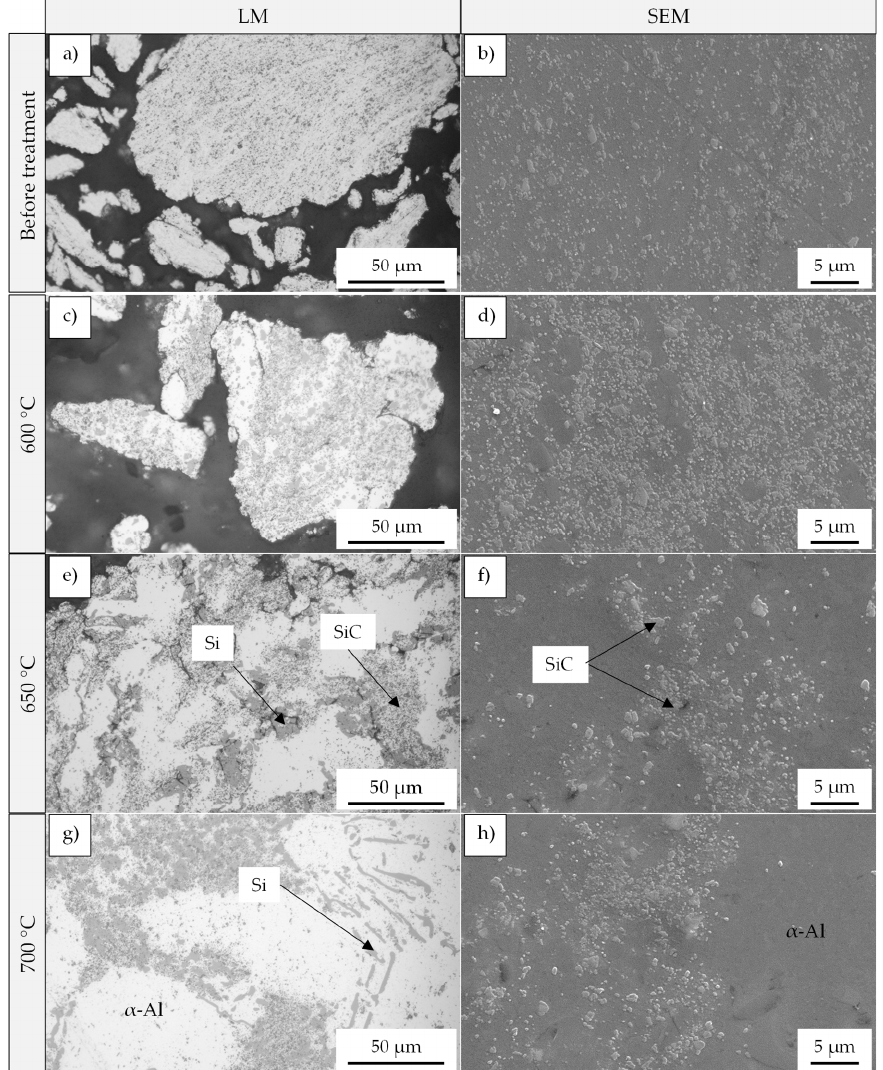
Figure 15. Heat treatment in tube furnace at different temperatures of composite powder (AlSi10Mg + 5 vol% SiC) milled with menthol. ( a , c , e , g ) light microscopic; ( b , d , f , h ) SE-SEM micrographs.